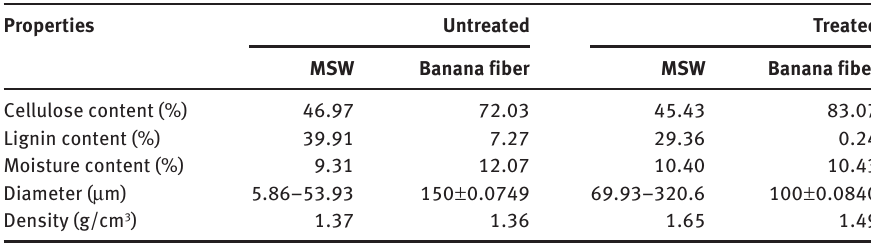
Table 1 Properties of untreated and treated MSW and banana